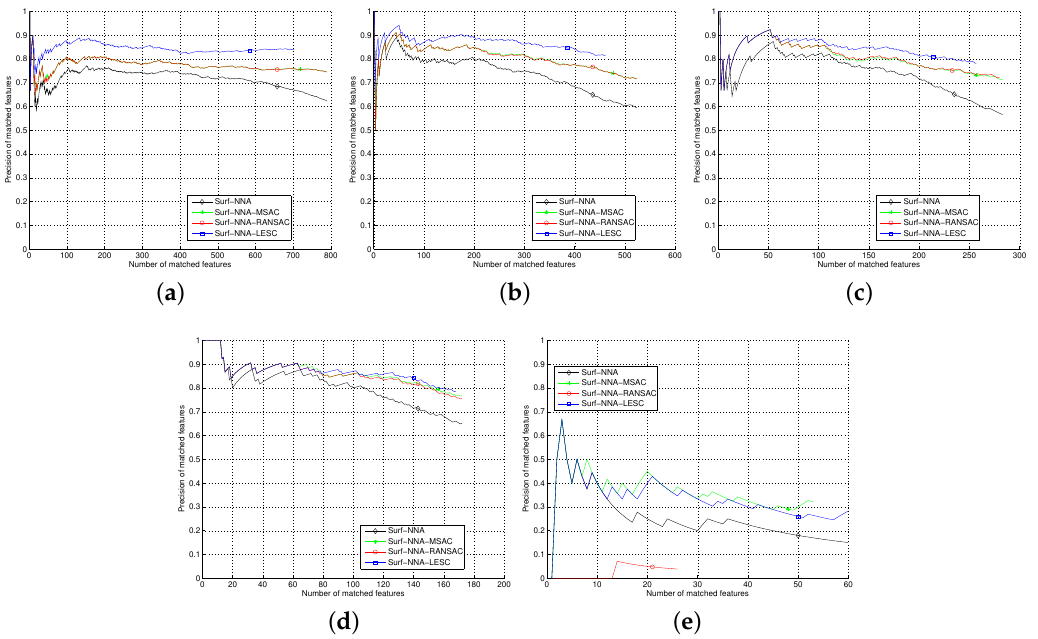
Figure 3. Scale change for the structured scene by the Boat sequence. From ( a ) to ( e ) the degree of change